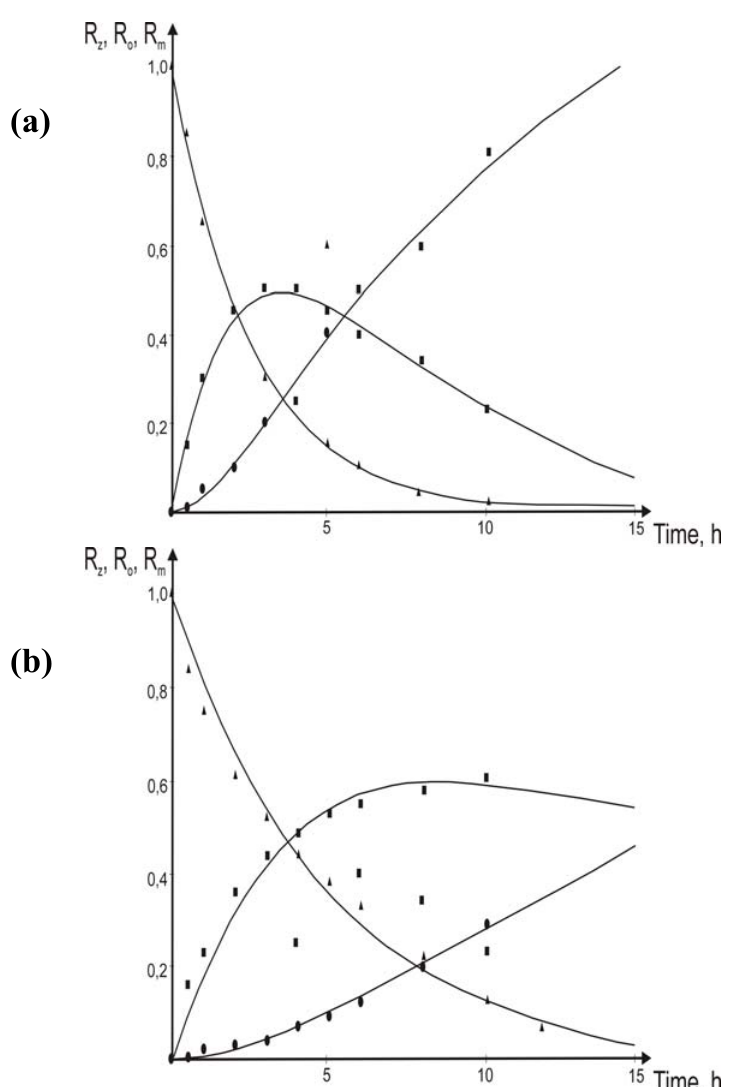
Figure 6. Variation of chromium(III) concentration at individual phases with time for a different initial chromium(III) concentration into the feed phase: (a) 1.9·10 -2 mol·dm -3 ;